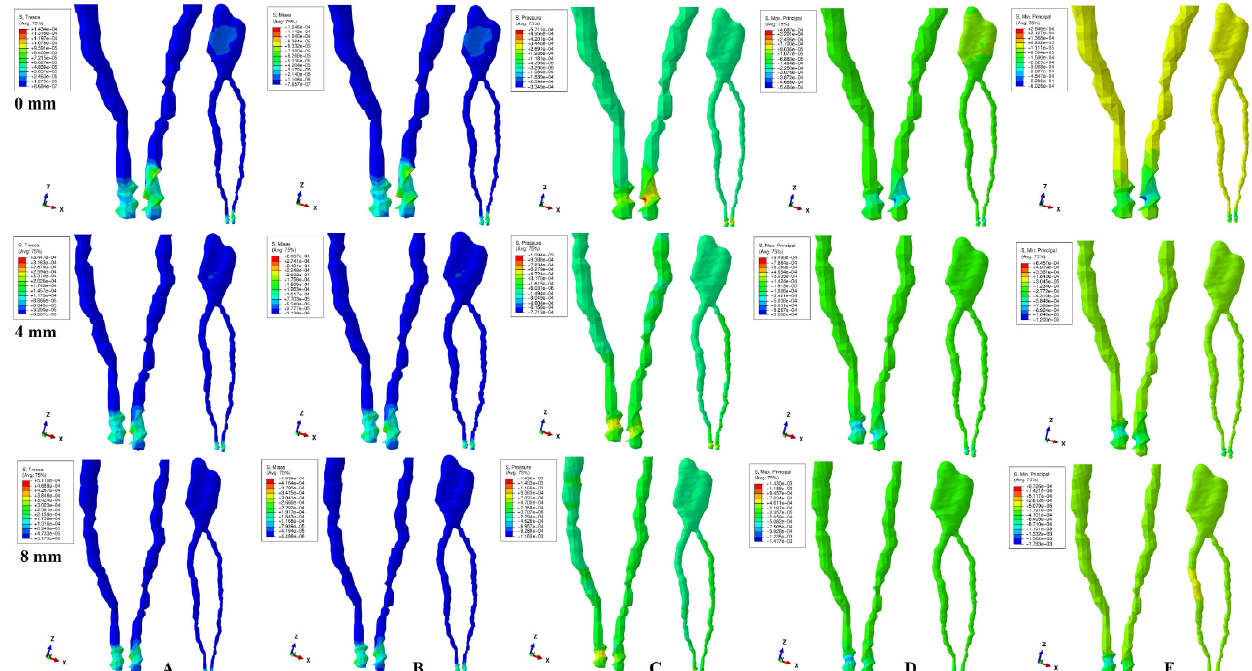
Figure 4. Stress distribution produced by rotation movement in the apical NVB and dental pulp of one of the nine models (intact, 4 mm and 8 mm reduced periodontium, vestibular-mesial view) in MPa: ( A )—Tresca, ( B )—Von Mises, ( C )—Pressure, ( D )—Maximum principal, ( E )—Minimum principal.